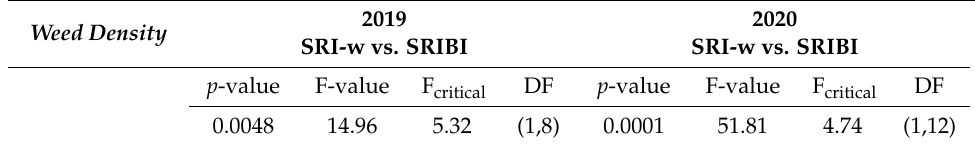
Table 2. Parameters from ANOVA statistical analysis for weed density comparison.